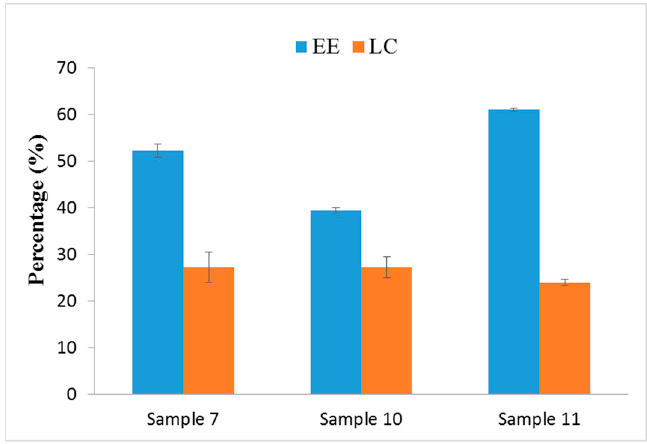
Figure 2. Entrapment efficiency (EE) and loading capacity (LC) of OMC/SiO 2 nanoparticles.